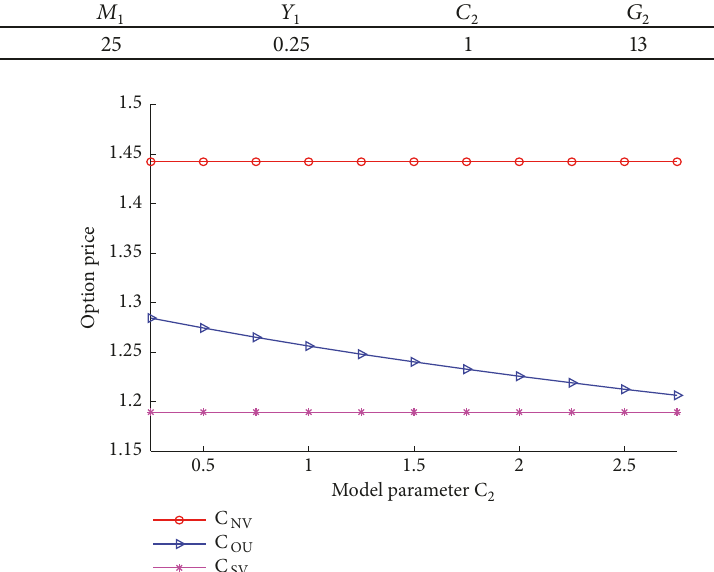
Figure 10: The effect of 𝐶 2 on the vulnerable option prices.